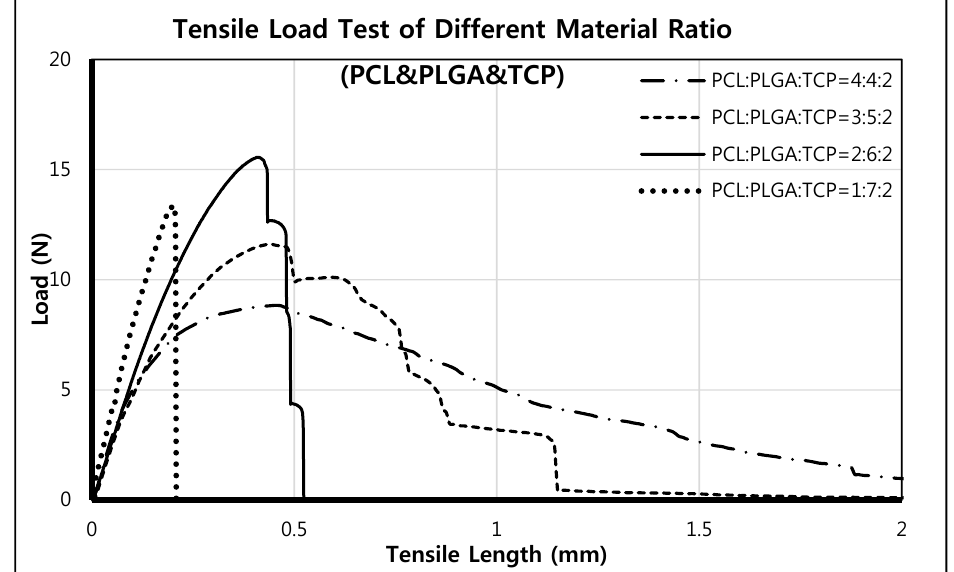
Figure 8. Tensile testing results of different material ratios (PCL/PLGA/ β -TCP). A PCL/PLGA/TCP ratio of 2:6:2 showed the highest mechanical strength.